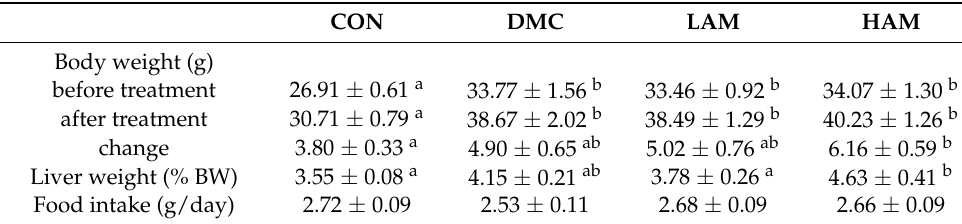
Table 1. Effect of AME on body weight, liver weight and diet intake in T2DM mice.